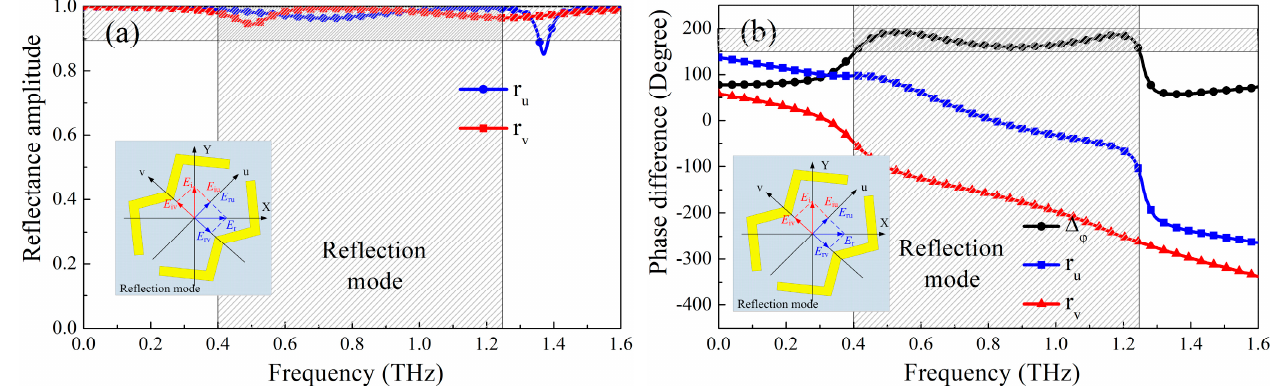
Figure 6. ( a ) Amplitudes and ( b ) phase of polarization conversion mode when the electric field of incident EM waves along the u-axis and v-axis for reflection mode, respectively.